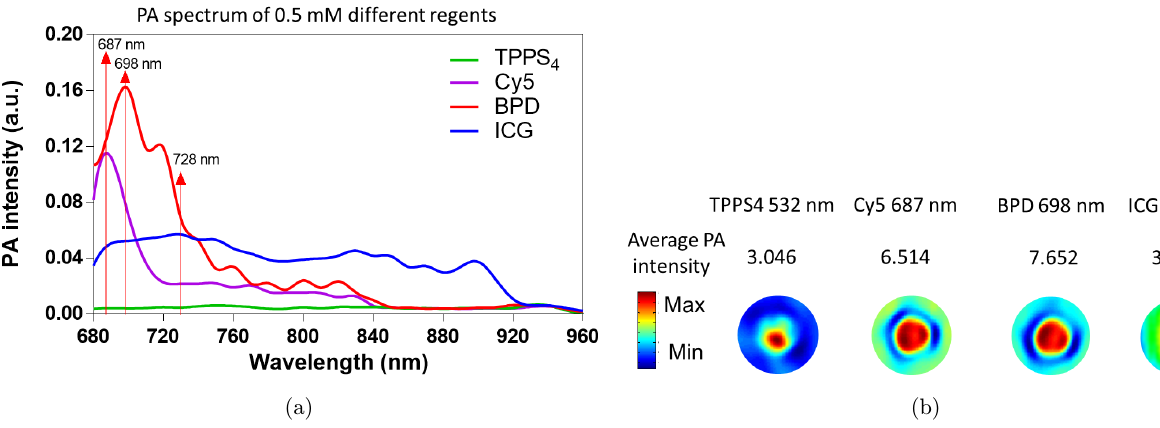
Fig. 2. (a) Photoacoustic spectrum of TPPS 4 , Cy5, BPD and ICG. (b) Phantom imaging of TPPS 4 , Cy5, BPD and